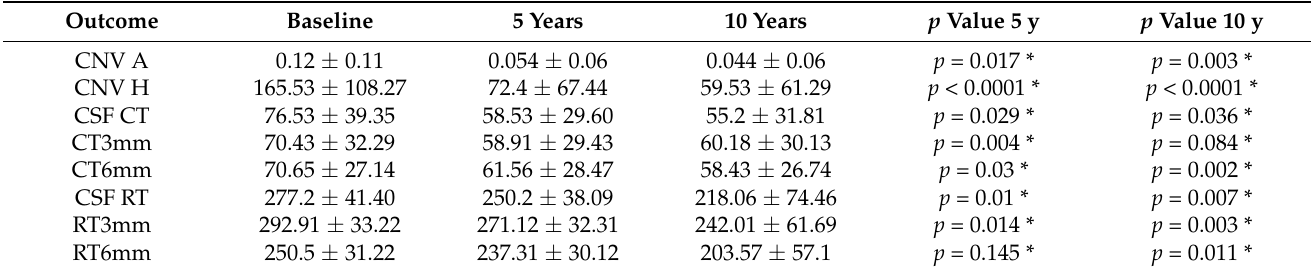
Figure 1. Spectral domain optical coherence tomography (SD-OCT) consecutive images ( A – C ) referring to baseline, 5-year and 10-year follow-up times of a 49-year-old female patient suffering from mCNV and treated with IVB (radial 20°, six lines scan protocol centred on the fovea). ( A ) Baseline scan showing an active juxtafoveal type 2 mCNV with macular thickening and minimal subretinal fluid. ( B ) Year 5 scan showing a residual highly reflective subretinal scar lesion with no associated fluid. ( C ) Year 10 scan showing complete regression of the mCNV lesion. Table 5. Anatomical outcomes after IVB treatment for